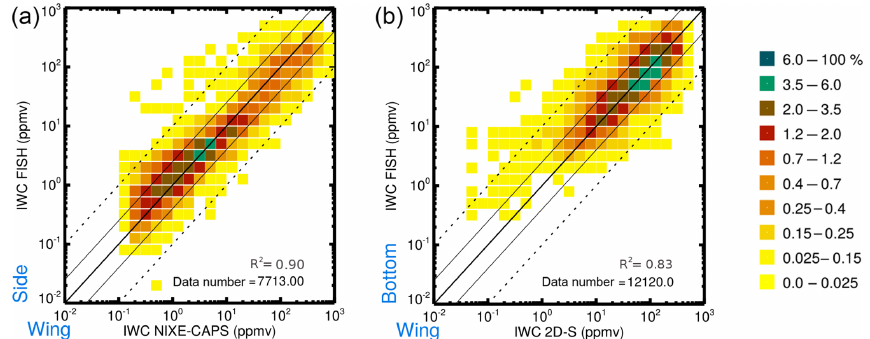
Figure 11. Comparison of IWCs from (a) side-mounted closed-path FISH (see Eq. 1, H 2 O gas from FLASH) and wing-mounted cloud spectrometer NIXE @Geophysica during StratoClim 2017; (b) bottom-mounted closed-path FISH (see Eq. 1, H 2 O gas from HWV) and wing-mounted cloud spectrometer 2D-S @WB-57 during MacPex 2011 (color code: frequencies; solid black: 1:1 line; dashed/thin: ± factor 10/2.5 to 1:1 line). Linear regression coefficients for X = IWC wing, Y = IWC side–bottom are (a) side–wing Y = 0 . 768 × X + 0 . 066, σ = 0 . 0045 and (b) bottom–wing Y = 0 . 856 × X + 0 . 174, σ = 0 . 0048; the correlation coefficients R 2 are shown in the respective panels. The side–wing regression is calculated for the data range > 0.15ppmv (lower detection limit